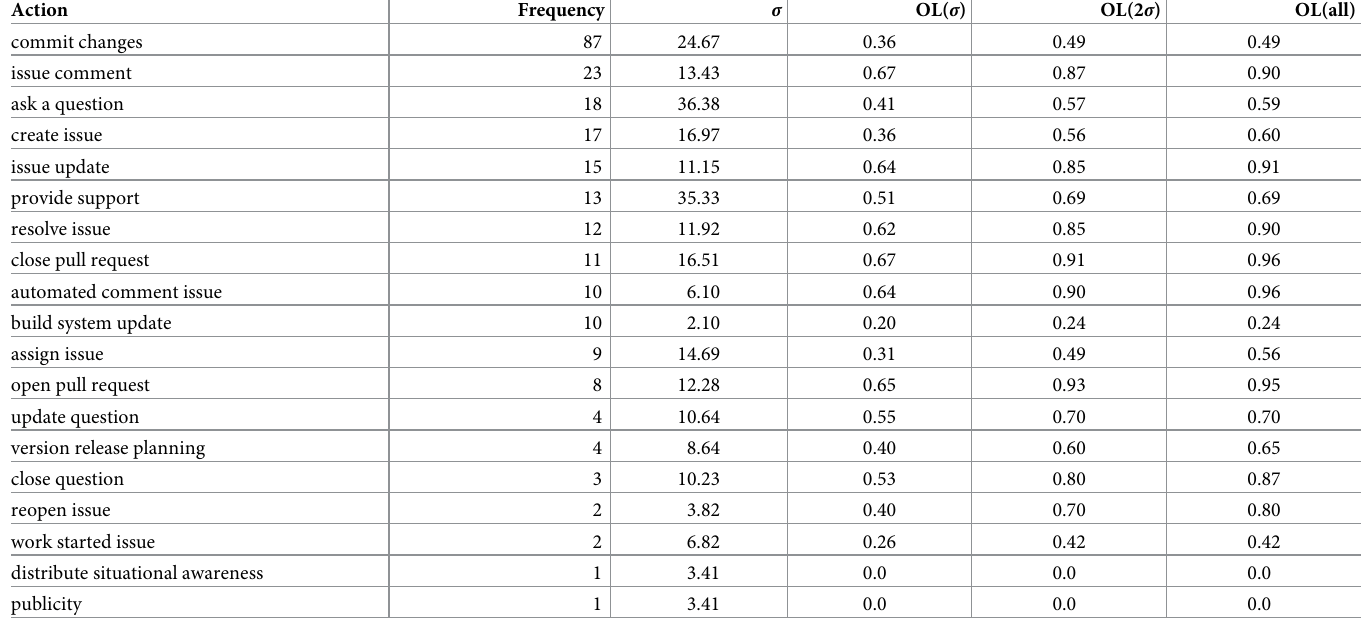
Table 5. Actions, and their observed frequencies, constructed from the traces, keywords, and metalabels during the Delphi process. σ denotes the standard deviation of the an action-keyword frequency distribution, and OL( σ ) the fractional overlap with other action-keyword frequency distributions within 1 σ .